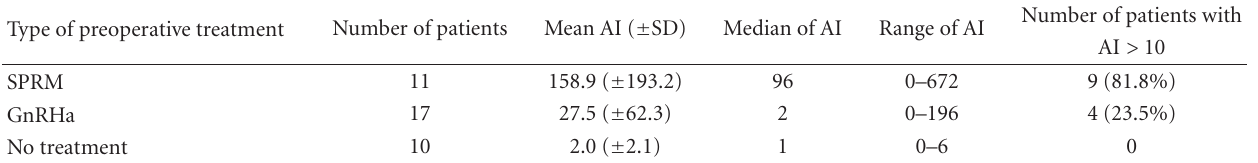
Table 2: Apoptotic index (AI) in the subgroups of the study.